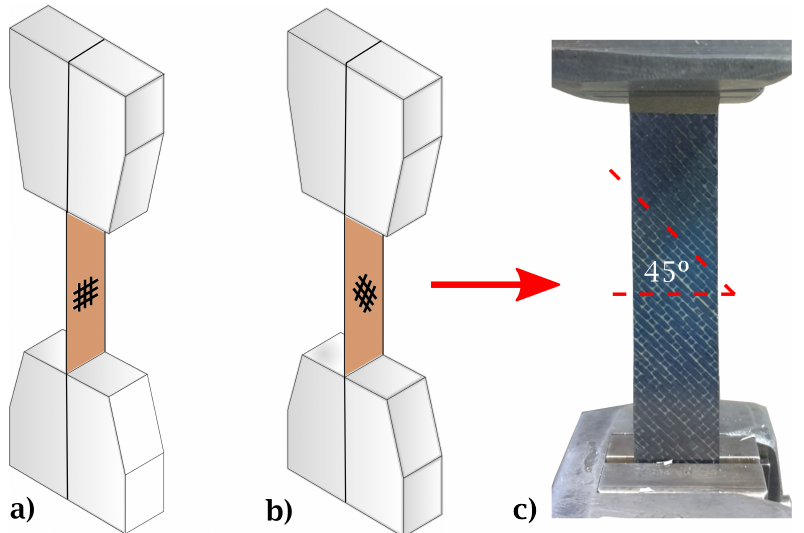
Figure 5. Schematic representation of tensile tests for fiber reinforcement configurations at ( a ) 0 ◦ /90 ◦ and ( b ) ± 45 ◦ with respect to loading direction. ( c ) Experimental setup (reinforcement at ± 45 ◦ ).